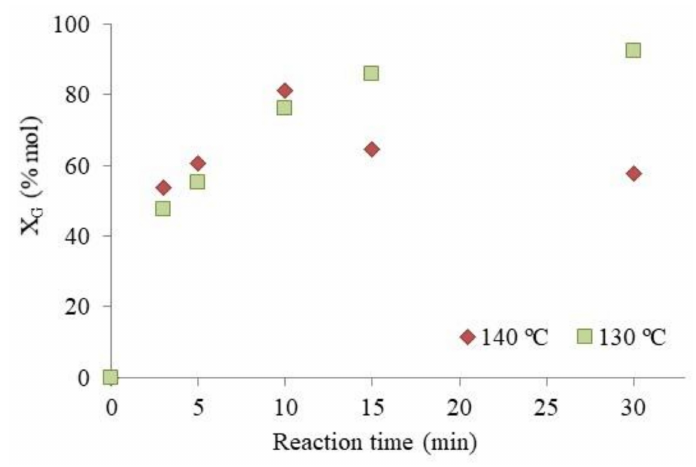
Figure 6. Glycerol conversion vs time profile over catalyst 1 at 130 ◦ C (green squares) and 140 ◦ C (red squares). Reaction conditions: TBA / G molar ratio = 4; catalyst amount 5